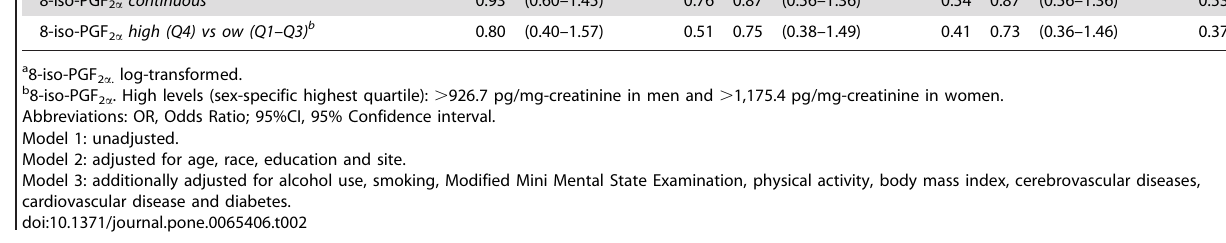
Abbreviations: OR, Odds Ratio; 95%CI, 95% Confidence interval. Model 1: unadjusted. Model 2: adjusted for age, race, education and site. Model 3: additionally adjusted for alcohol use, smoking, Modified Mini Mental State Examination, physical activity, body mass index, cerebrovascular diseases, cardiovascular disease and diabetes.